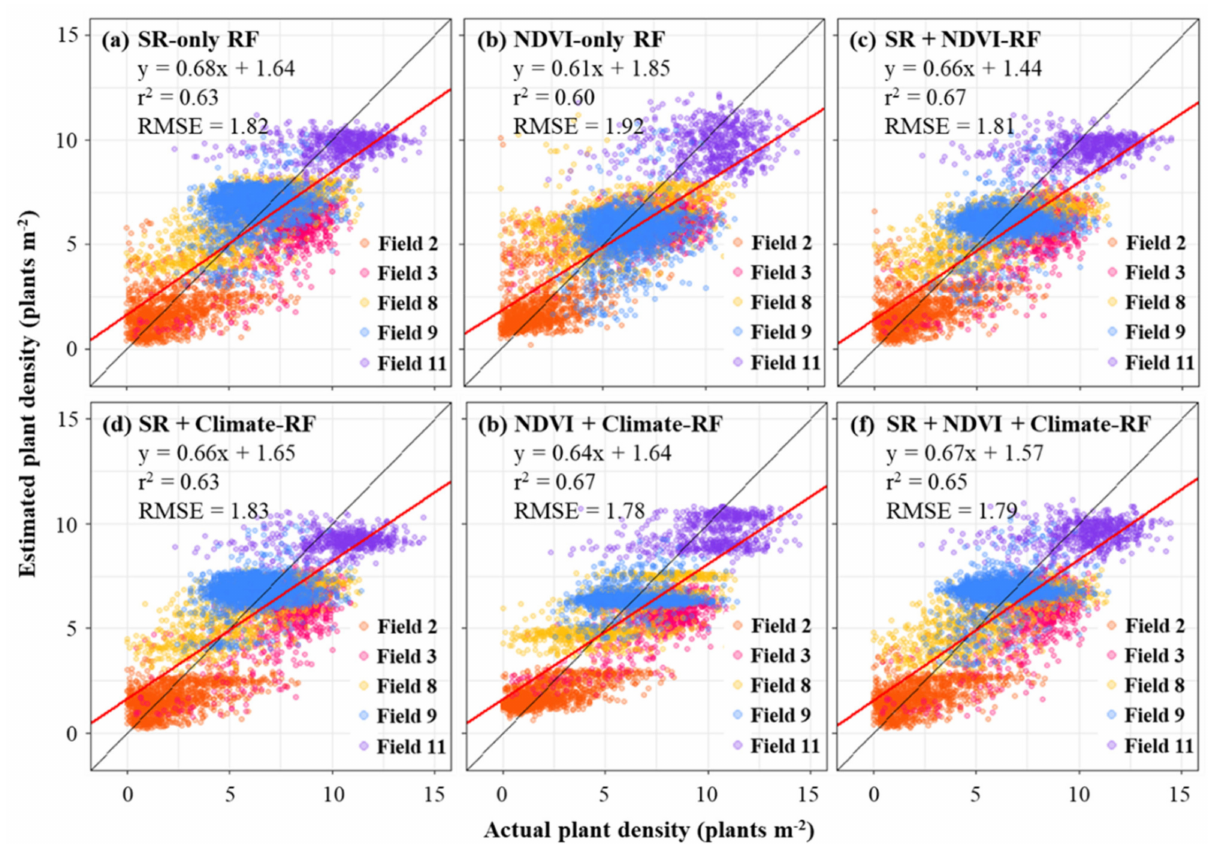
Figure 7. Relationships between actual plant density derived from the YOLOv3 model and estimated plant density (plants m − 2 ) derived from ( a ) SR-only RF; ( b ) NDVI-only RF; ( c ) SR + NDVI-RF; ( d ) SR + Climate-RF; ( e ) NDVI + Climate- RF; ( f ) SR + NDVI + Climate-RF of the test data set. The red line represents a regression line. The black line represents a 1:1 relationship. Different color points represent the field